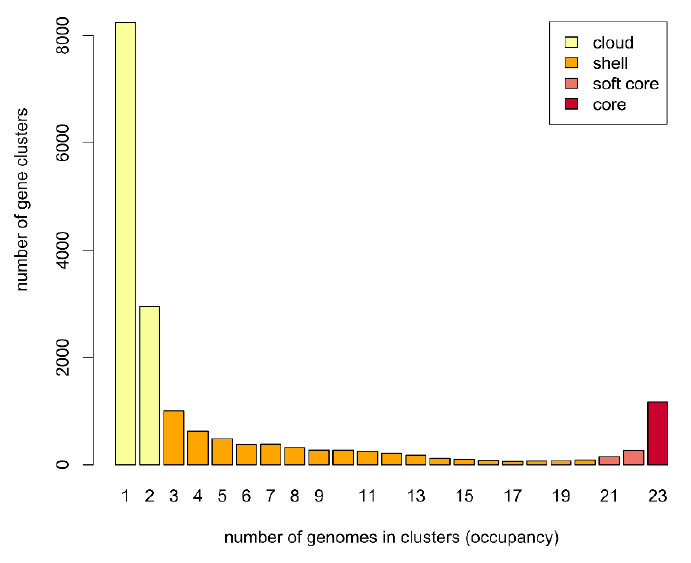
Figure 2. Barplot of the pan-genome matrix.